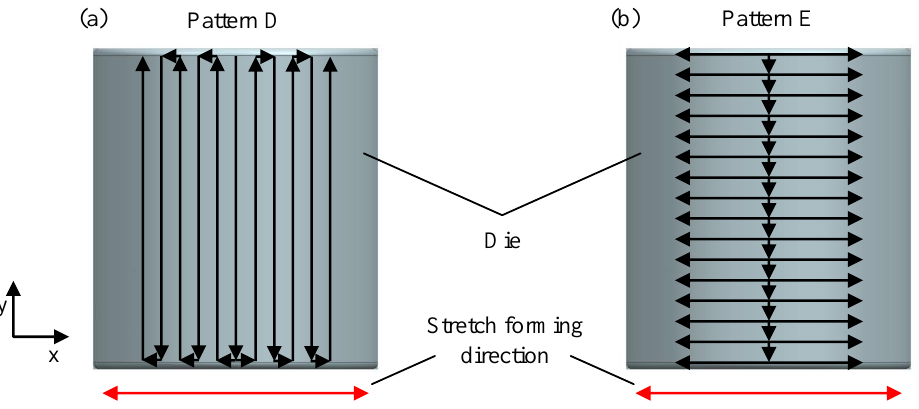
Figure 4. Experimental setup before forming ( a ) and after stretch forming and ISF ( b ). Figure 5. Schematic representation of the die (top view) with the tested path Patterns D ( a ) and E ( b ).